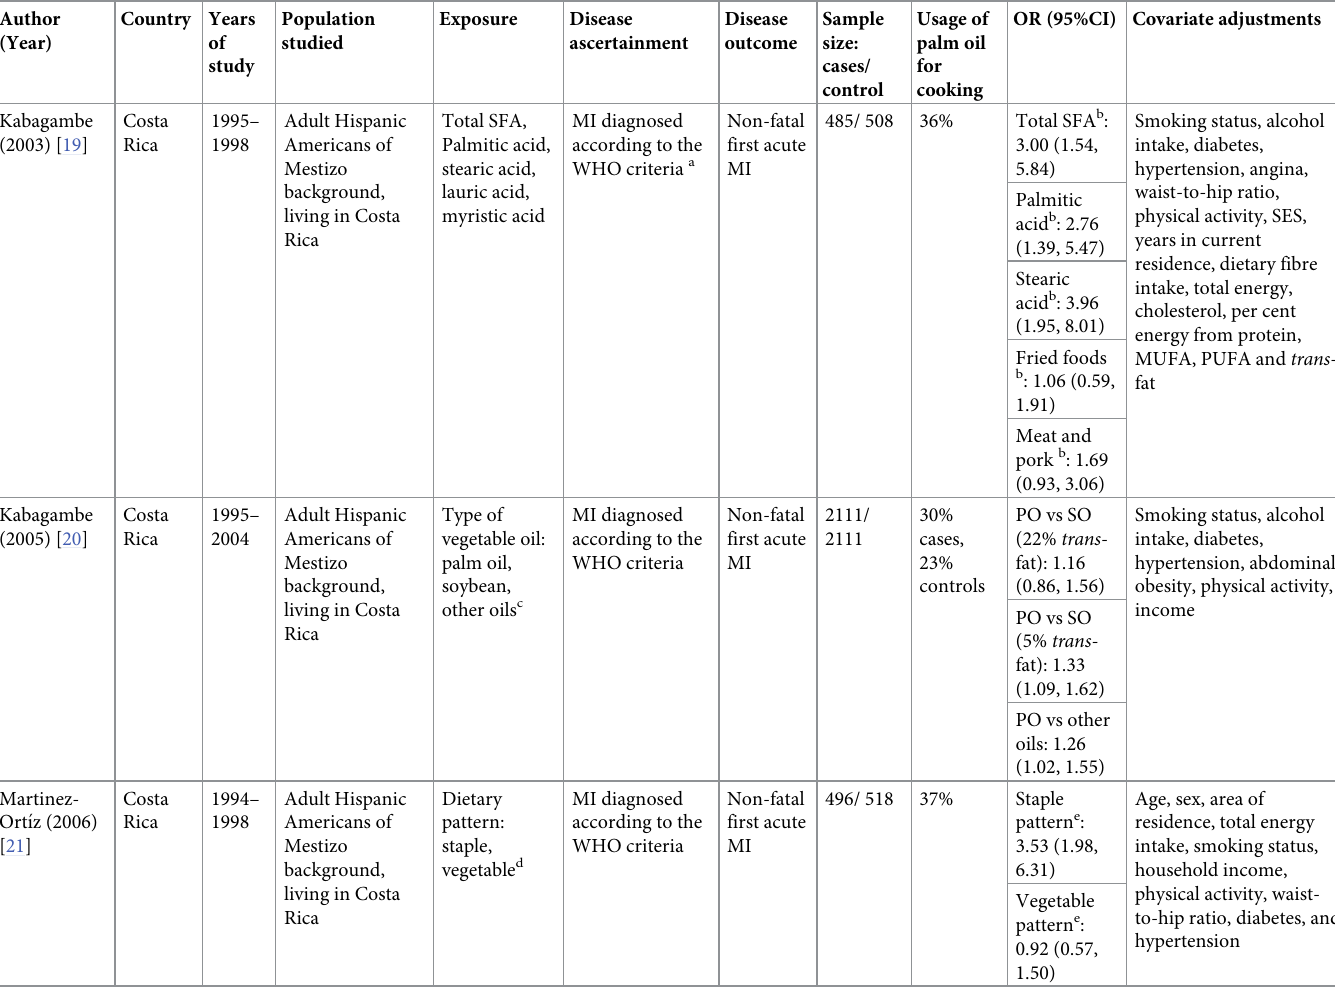
Table 1. Characteristics of the three included studies reporting the association of palm oil consumption and CHD